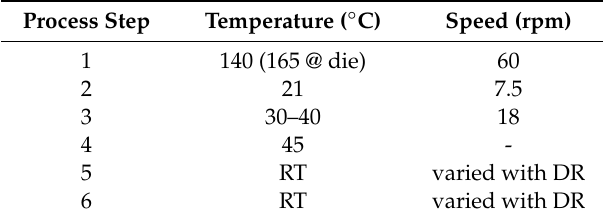
Table 2. Description of the samples and their